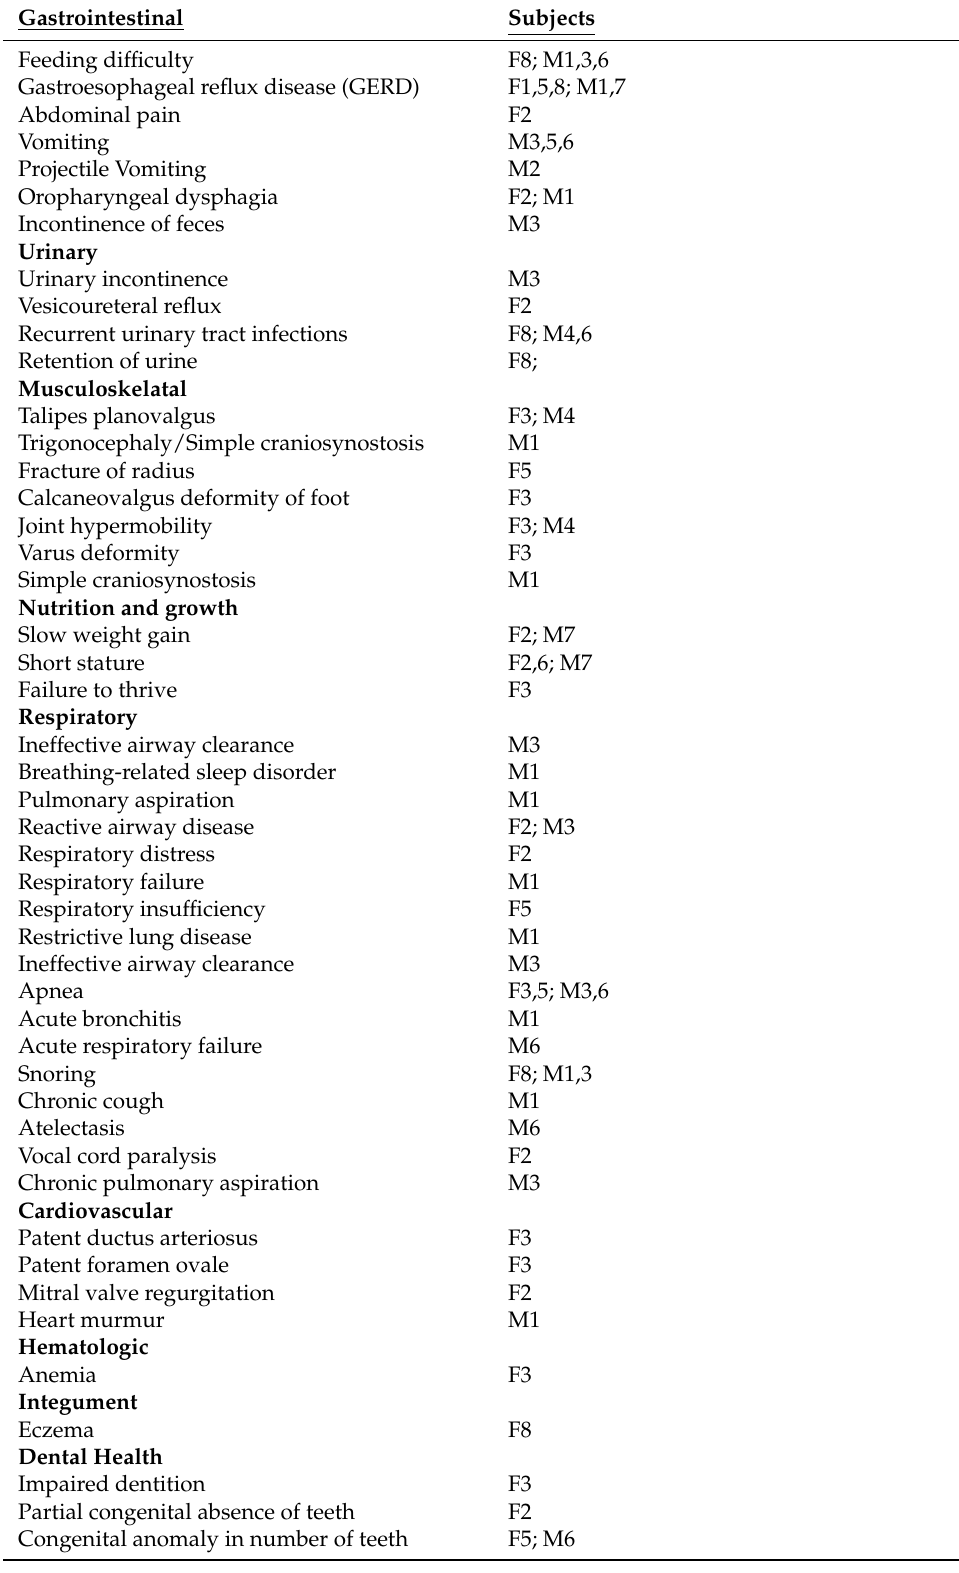
Table 2. All non-neurologic diagnoses are listed with each patient carrying that diagnosis on one or more